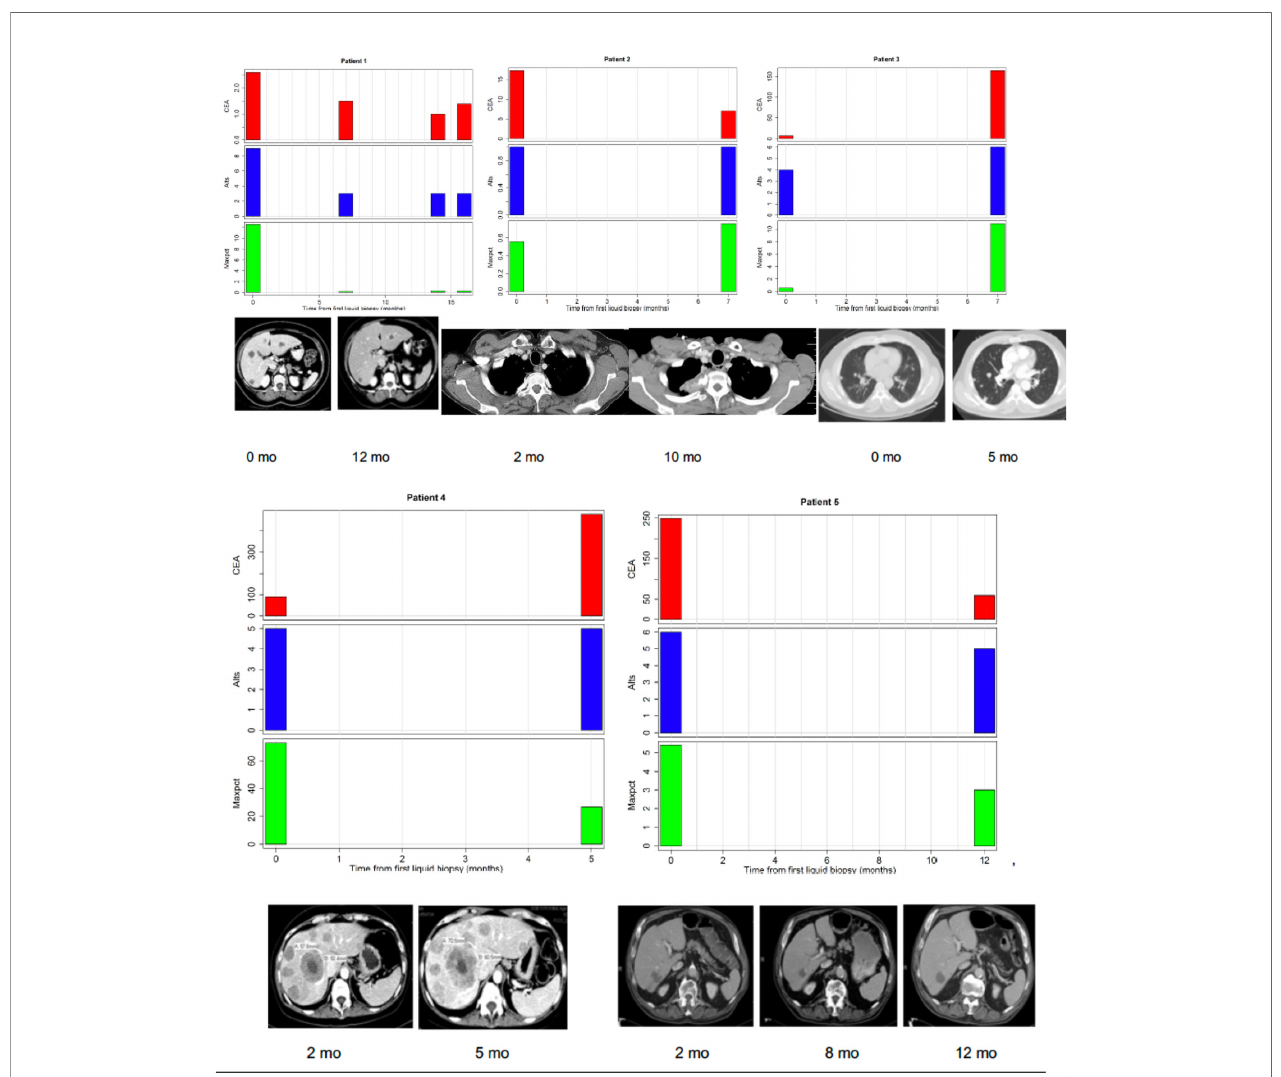
FIGURE 3 | Correlations between tumor burden as assessed by radiographic imaging (CT scans) or CEA (tumor marker) and liquid biopsy mutation parameters (alts or number of alterations/number of mutated genes and maxpct or maximal allele frequency of mutated allele). (Top Left) Maxpct, CEA, and alts follow a downward trend as disease on CT scan improves. Center: With growth of mediastinal mass on CT, note rise in maxpct, CEA, and alts. (Top Right) As lung disease worsens on CT, maxpct, CEA, and alts increase. (Bottom Left) Despite increasing tumor on CT scan and rising CEA, maxpct did not rise. Liquid biopsy did contain APC and TP53 mutations, indicating presence of ctDNA. (Bottom Right) Liver metastases decreased between 1/2017 and 7/2017 and then increased in 11/2017. Allele freq. low (2 – 4%) probably due to low disease burden on